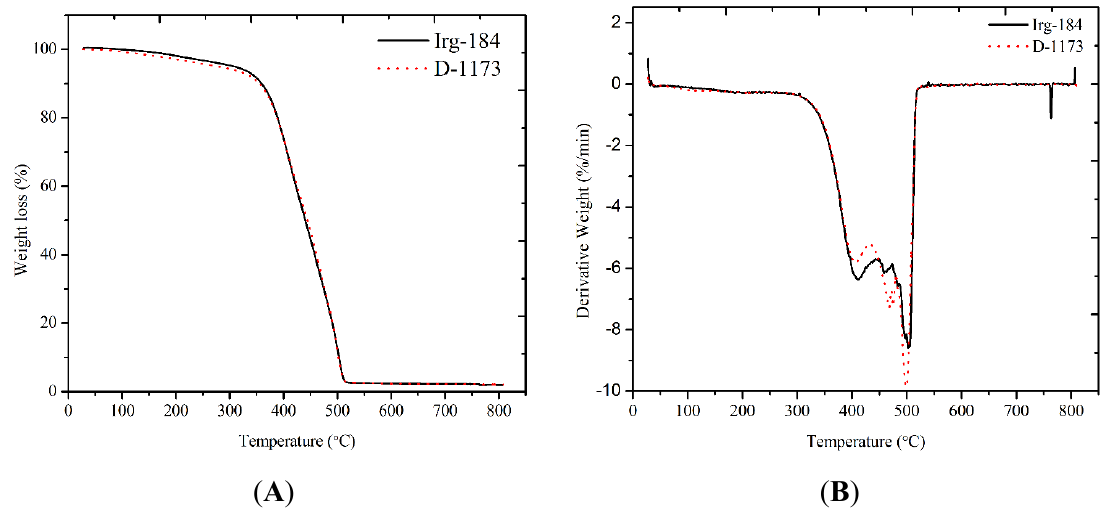
Figure 11. ( A ) TGA Thermograms and ( B ) Derivatives Curves of EPOLA Films with D-1173 and Irg-184